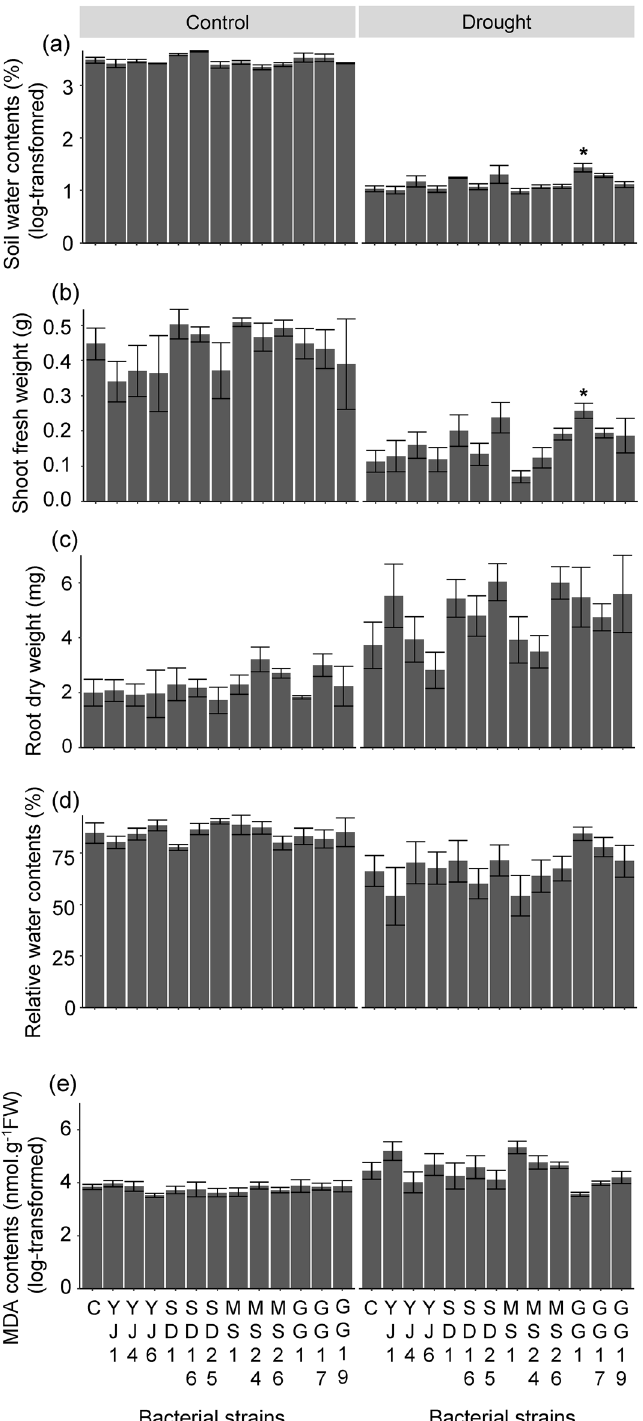
Figure 5. Effects of seed endophytic bacteria on A. thaliana growth and soil water content under drought conditions. ( a ) Soil water contents. ( b ) Shoot fresh weight. ( c ) Root dry weight. ( d ) Relative water content. ( e ) Malondialdehyde (MDA) content. Data are presented as mean ± SE. Results of multiple comparisons with Dunnett adjustment are indicated above each bar. * P < 0.05. C: negative